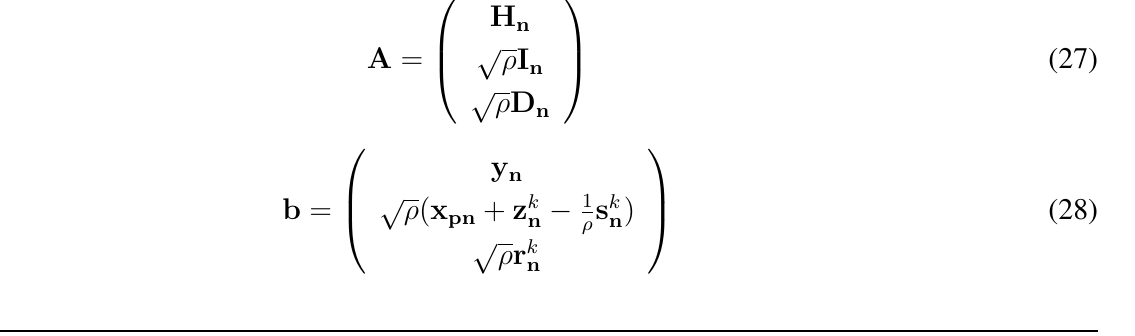
Algorithm 2 D-LCD with a warm